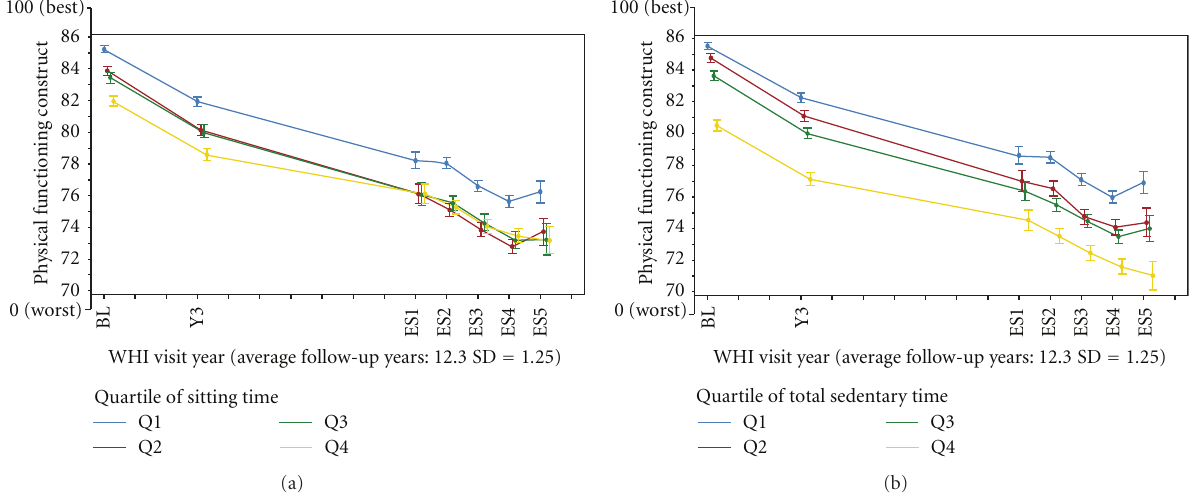
Figure 1: (a) Physical function score over time by baseline sitting time, N = 61,609. (b) Physical function score over time by baseline total sedentary time, N = 61,609.